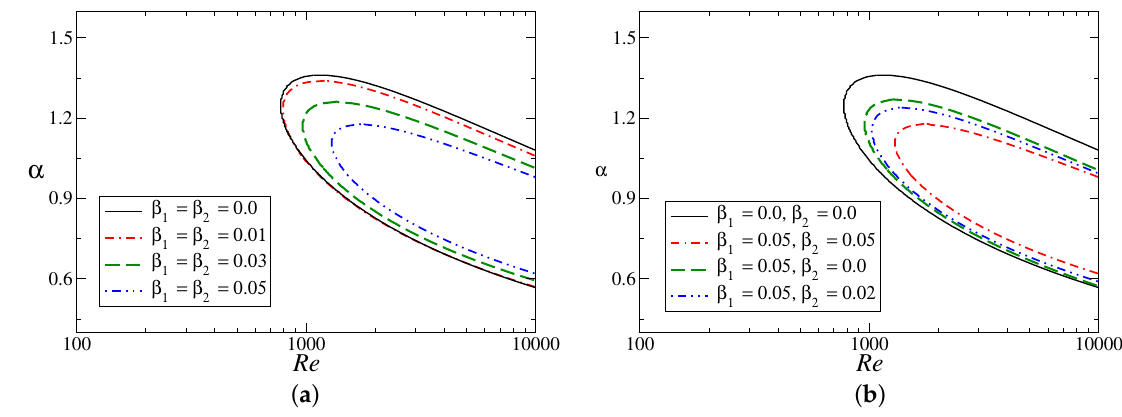
Figure 6. Neutral stability boundaries for σ 1 = 0, σ 2 = 0.2: ( a ) symmetric slip ( β 1 = β 2 ); and ( b ) non-symmetric slip ( β 1 (cid:54) = β 2